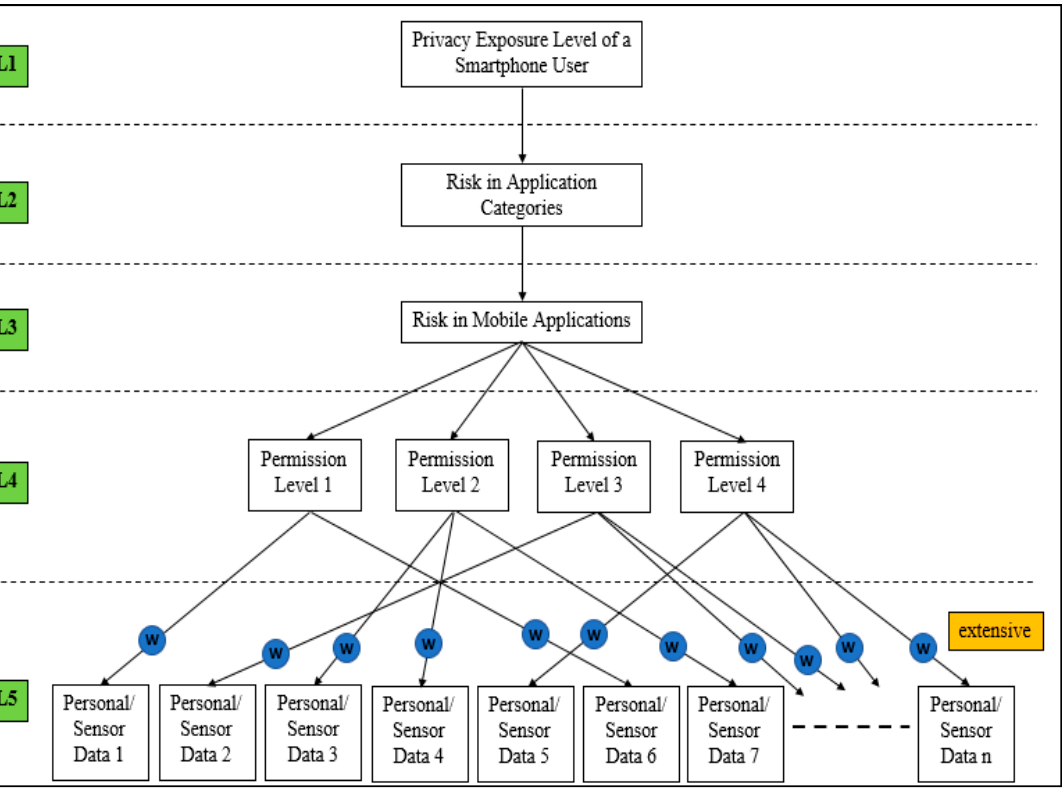
Figure 2. Detailed tree structure.